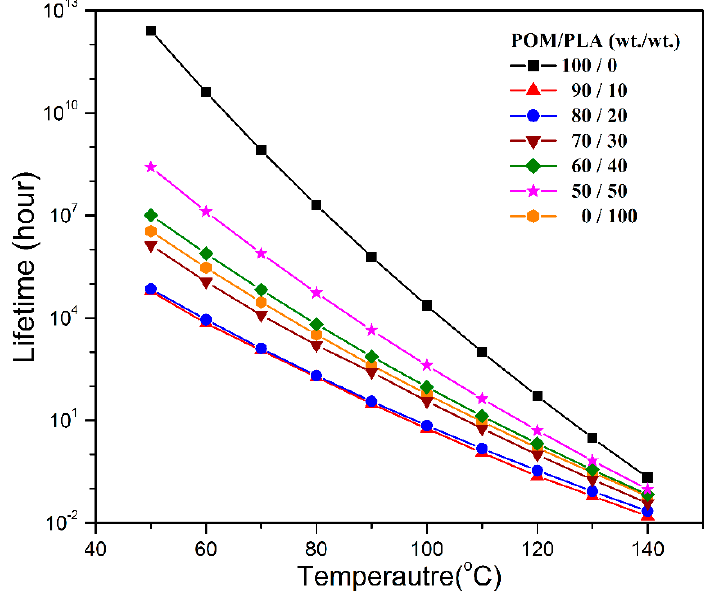
Figure 14. Plots of lifespan as a function of temperature predicted by the Loop method for pure POM, PLA, and their